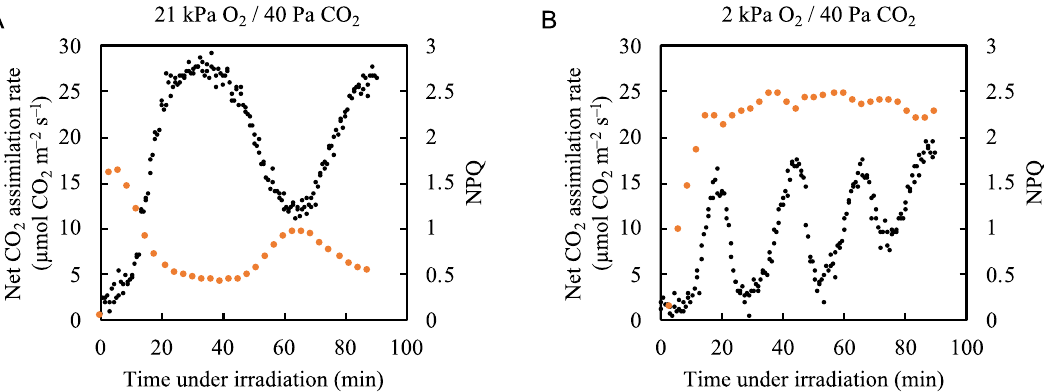
Figure 5. E ff ects of partial pressure of O 2 on the relationship between the net CO 2 assimilation rate and non-photochemical quenching (NPQ) of chlorophyll fluorescence in rice leaves. NPQ of chlorophyll fluorescence (orange circle) was measured simultaneously with the net CO 2 assimilation rate (black circles) under ( A ) 21 kPa O 2 / 40 Pa CO 2 and ( B ) 2 kPa O 2 / 40 Pa CO 2 conditions. Actinic light (700 µ mol photons m –2 s –1 ) was turned on at 0 min. The data for the net CO 2 assimilation rate under 21 kPa O 2 / 40 Pa CO 2 and 2 kPa O 2 / 40 Pa CO 2 are the same as those used for Figure 2A and 2B, respectively.